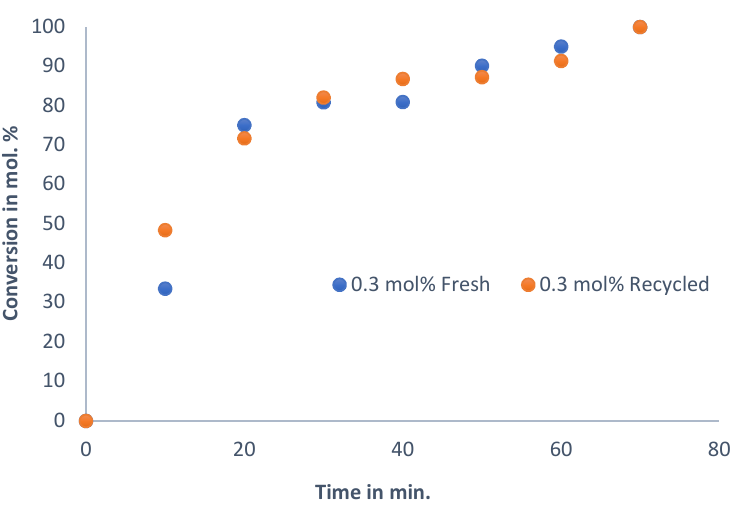
Figure 6. Reaction profile of fresh catalyst and recycled catalyst (4th cycle) at 10-min intervals.